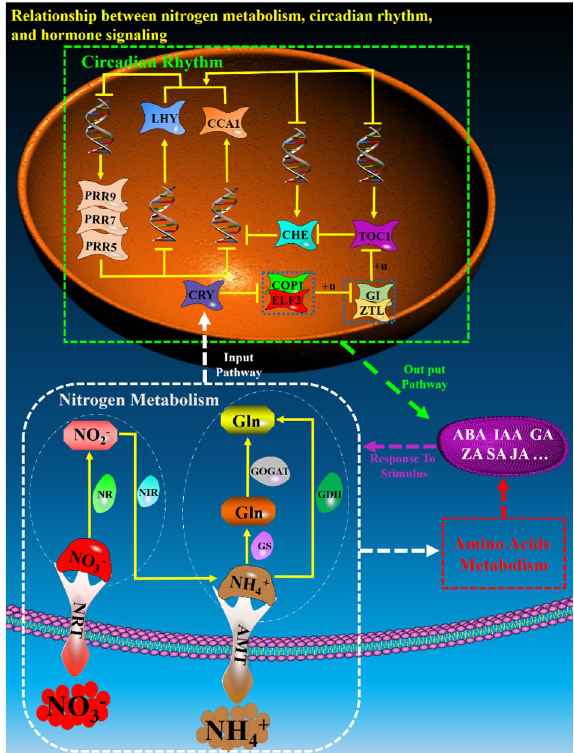
Figure 6. Hypothetical model showing the mutual regulation of nitrogen metabolism, circadian rhythms, and hormone signal transduction. The combination of two rows of purple balls with yellow connections between them represents the cell membrane, and the orange ellipse represents the cell nucleus. Dashed arrows, solid arrows, and T-shaped segments represent possible input and output pathways, activation, and inhibition, respectively. The thin white dotted line is used to distinguish NO 3 - reduction and NH 4 + assimilation in nitrogen metabolism, while the blue dotted boxes in the circadian rhythm pathway represent protein complexes. The white, green, and red thick dotted boxes and the purple ellipse represent nitrogen metabolism, circadian rhythms, amino acid metabolism, and hormone signal transduction pathways, respectively. From bottom to top, the cluster of red and brown balls represents NO 3 - and NH 4 + outside the cell, respectively; the ‘tree’-shaped molecules represent the transmembrane transporters NRT and AMT; the ‘caps’ on the transmembrane proteins represent NO 3 - and NH 4 + transported into the cell; hexagons with different colours represent various products of nitrogen metabolism; in the nitrogen metabolism pathway, irregular shapes with different colours attached to each line represent different enzymes of nitrogen metabolism; in the circadian rhythm pathway, irregular shapes with different colours represent different proteins; the double helix structure represents DNA; and the ‘ + u’ around the solid line represents